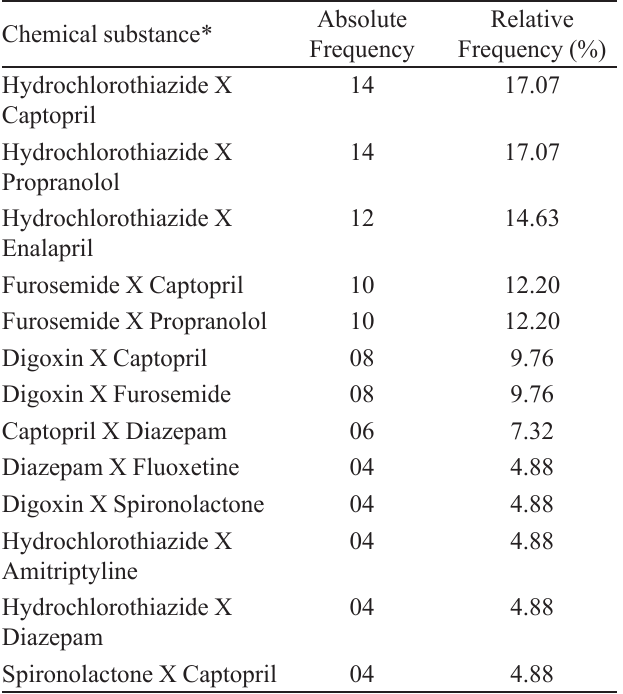
TABLE III - Absolute and relative frequencies of drug interactions